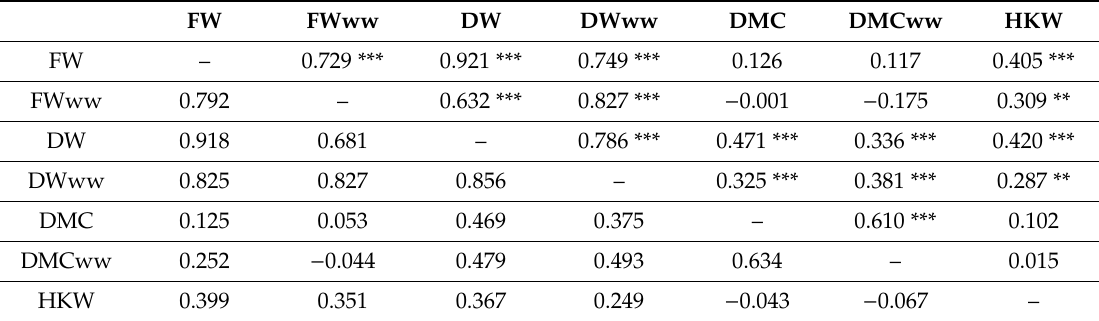
Table 2. Pearson’s correlation coe ffi cients (upper triangle) among fresh weight (FW), dry weight (DW), dry matter content (DMC) between control and water withholding (ww) treatments and with hundred kernel weight (HKW). Lower triangle represents Pearson’s correlations between BRR estimates of marker e ff ects between traits. ** represents significance at α = 0.01, *** represents significance at α = 0.001. All correlations among BRR marker e ff ects are significant at α = 0.001. FW